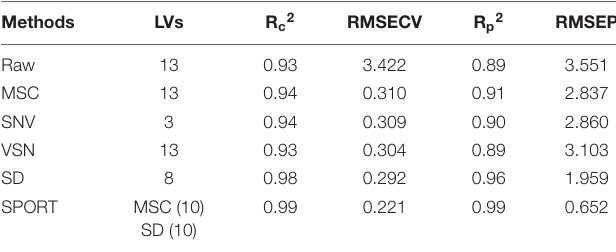
TABLE 3 | The parameters of the quantitative analysis model.